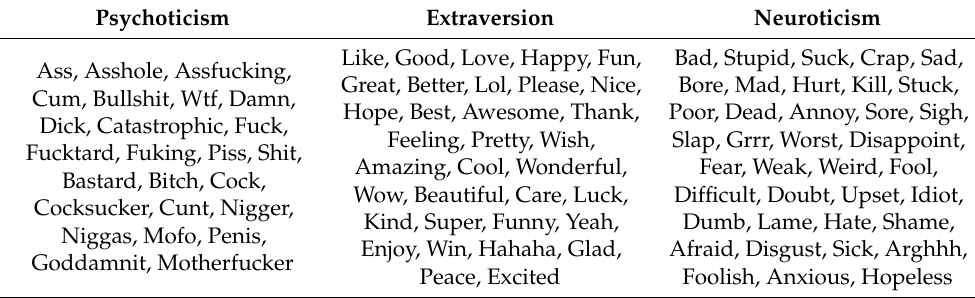
Table 2. Example of seed words from our preliminary study and AFFIN corpus